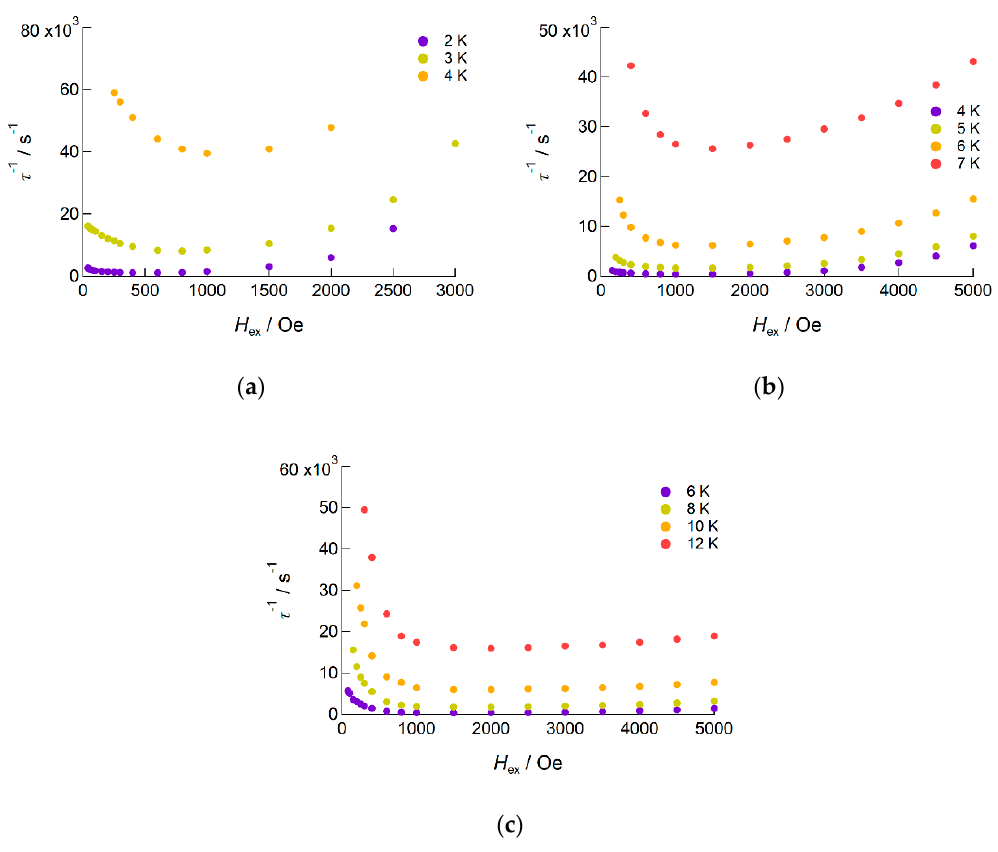
Figure 4. DC field dependence of the relaxation rate τ − 1 of ( a ) 1 , ( b ) 2 , and ( c ) 3 measured in the temperature ranges of 2 to 4 K, 4 to 7 K, and 6 to 12 K, respectively.